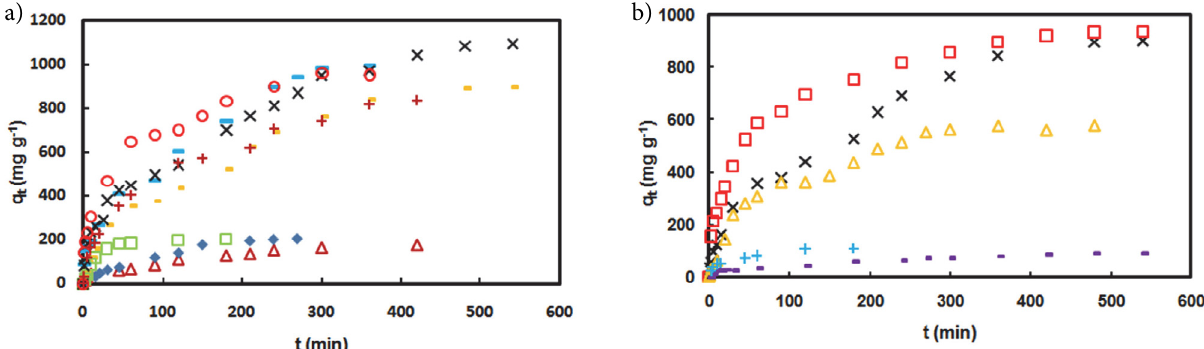
Figure 11. Kinetic curves of adsorption of ARS on GO/PAMAM (a) at ♦ pH = 0 and 0.25 mM ARS and  pH = 2 and 0.07 mM ARS at 318 K and 100 rpm; at pH = 2, 0.7 mM ARS and – 308, × 318 and  328 K at 100 rpm; at ∆ pH = 2, 0.07 mM ARS, 318 K and 100 rpm; at pH = 2, 0.7 mM ARS and 318 K at - 40 and + 70 rpm, respectively and (b) at × pH = 2, 0.7 mM ARS, 318 K and 40 rpm; at  pH = 3 and 0.7 mM ARS, ∆ pH = 5 and 1 mM ARS, - pH = 10 and 0.07 mM ARS and + pH = 13 and 0.07 mM ARS at 318 K and 100 Table 4. TRAKs for adsorption of ARS on GO/PAMAM in water, alkaline and acidic solutions at 100 rpm and 308–328 K. Solvent